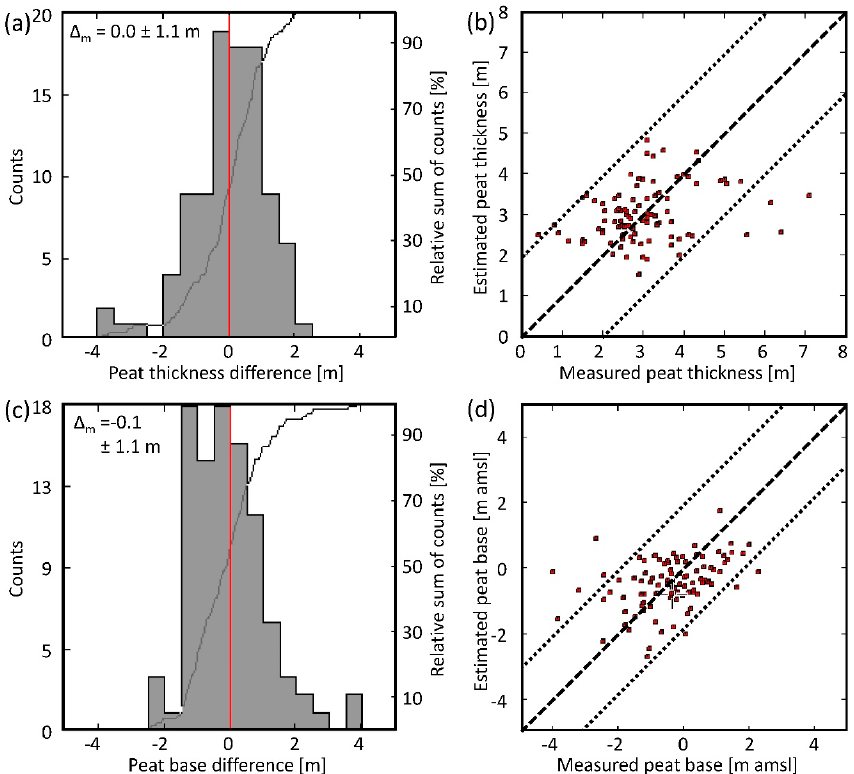
Figure 19. Comparison of airborne and borehole data: histograms of differences and scatter plots of peat thicknesses ( a , b ) and elevations of peat base ( c , d ) (vertical red lines: ∆ m = 0 lines; dashed and dotted lines: 1:1 lines and ±2 m lines).